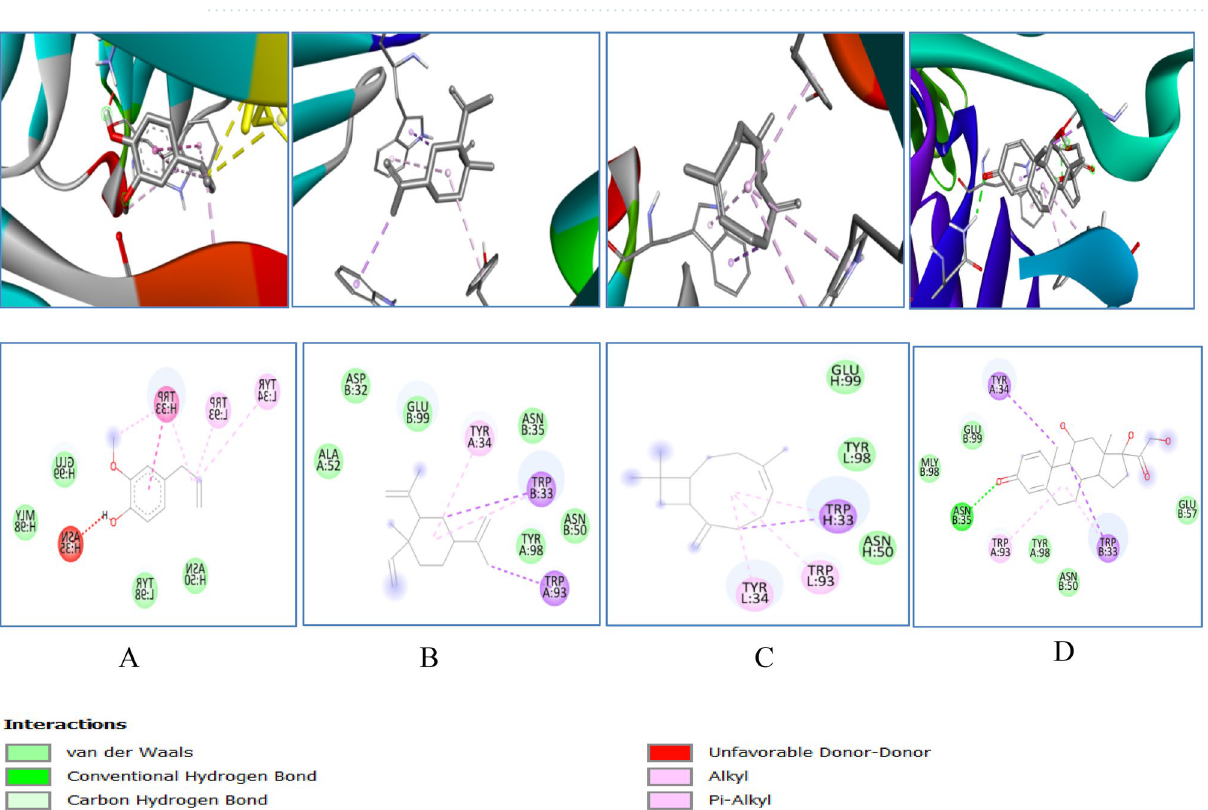
Figure 11. 3D (to the upper panel) and 2D (to the lower panel) interaction diagrams of ( A ) Eugenol, ( B ) Cyclohexane ( C ) Caryophyllene ( D ) Prednisolone with the crystal structure of Catalase (PDB ID: